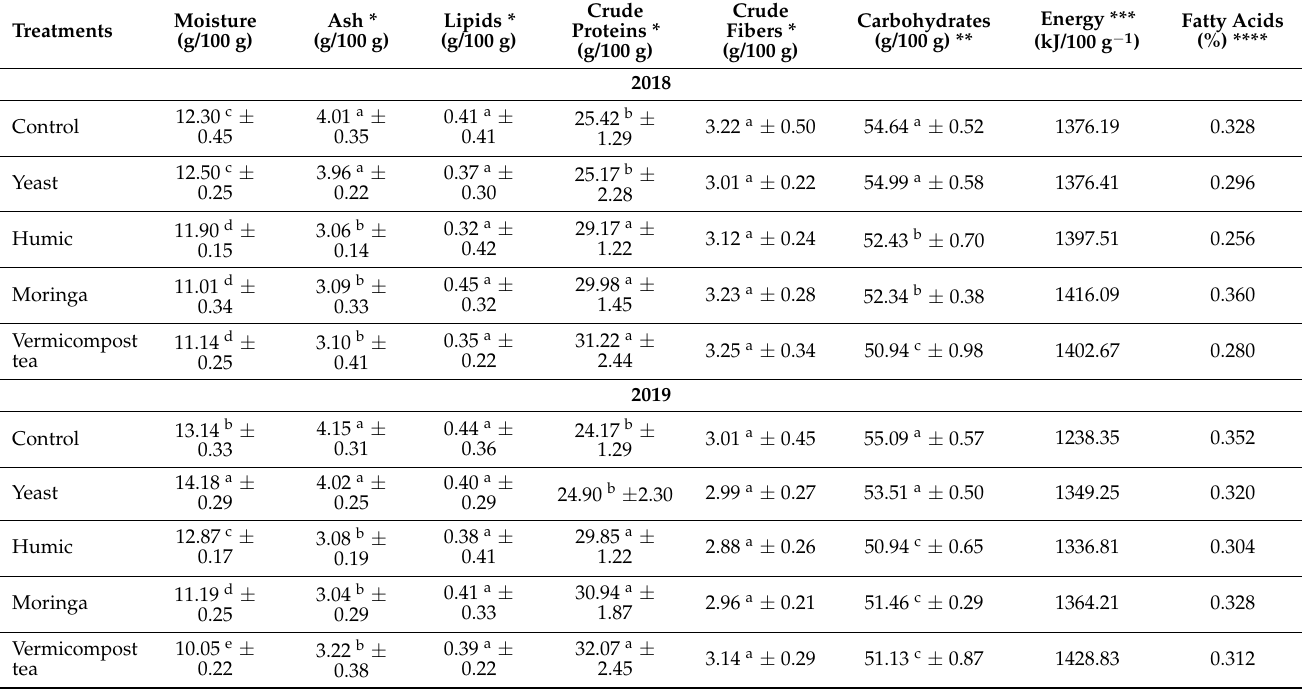
Table 8. Effect of biostimulants on the proximate chemical composition (%) of snap bean in growing seasons of 2018 and 2019.